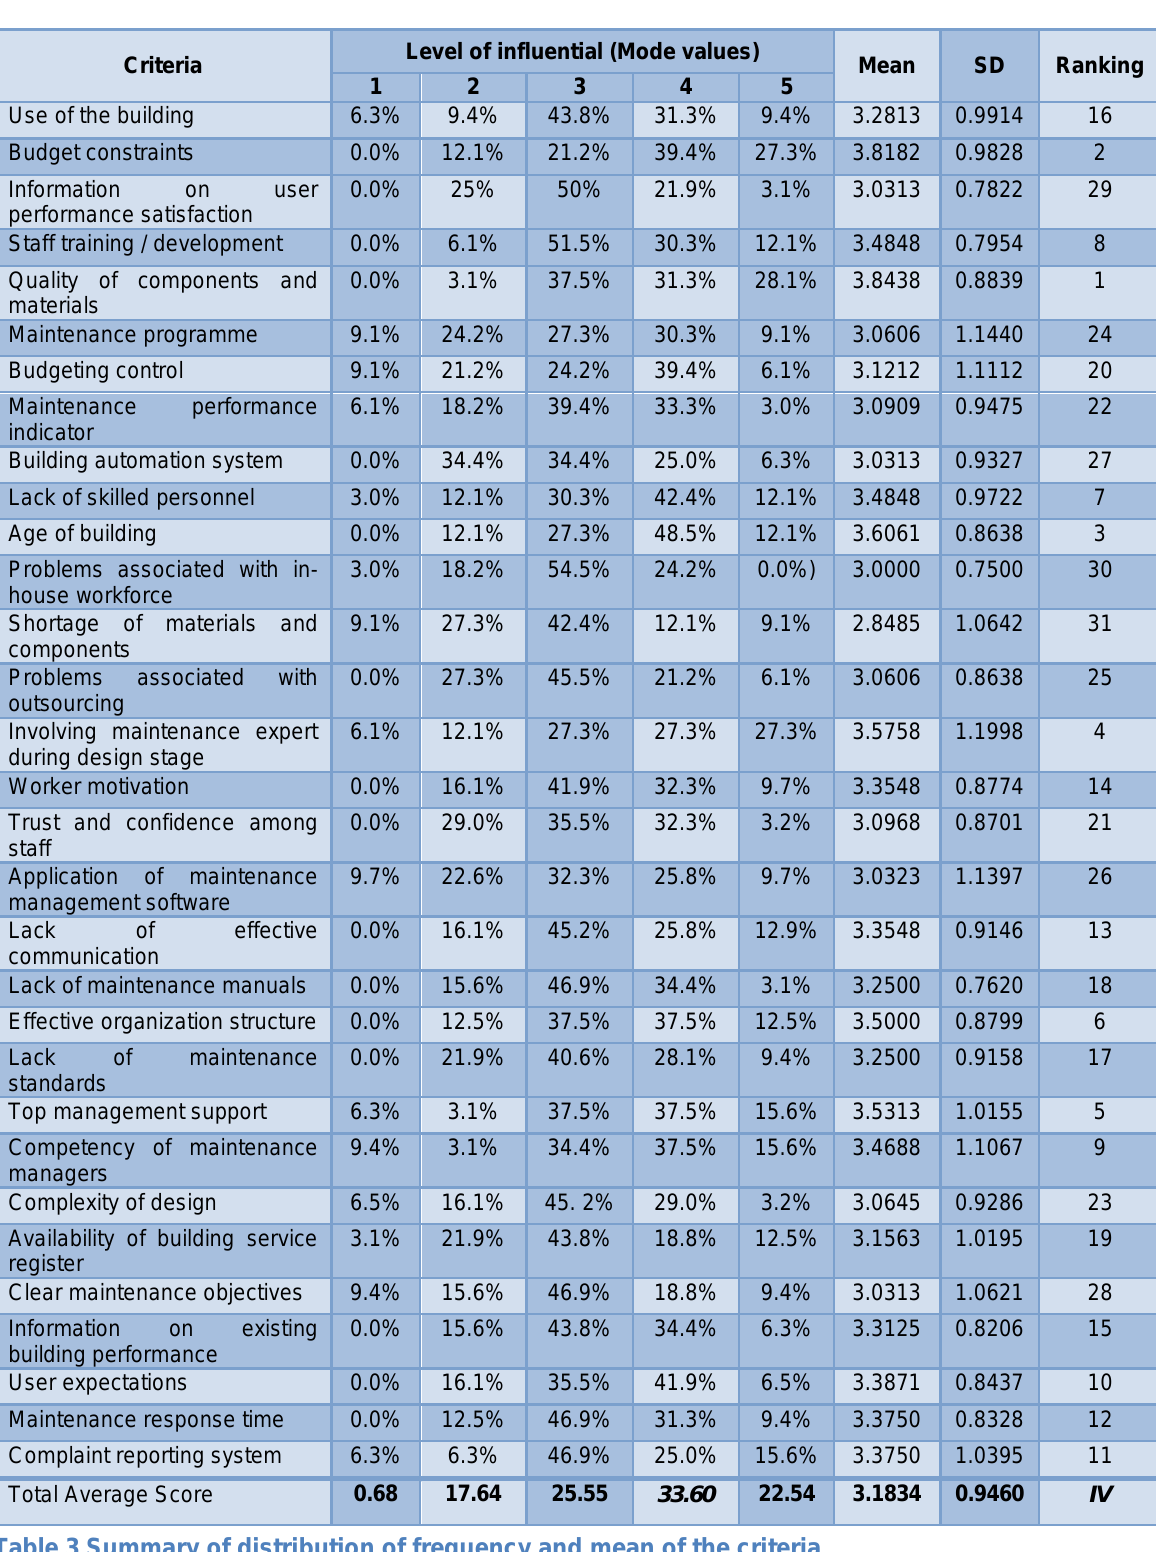
Table 3 Summary of distribution of frequency and mean of the criteria Note: VI= Very Influential, SD = Standard